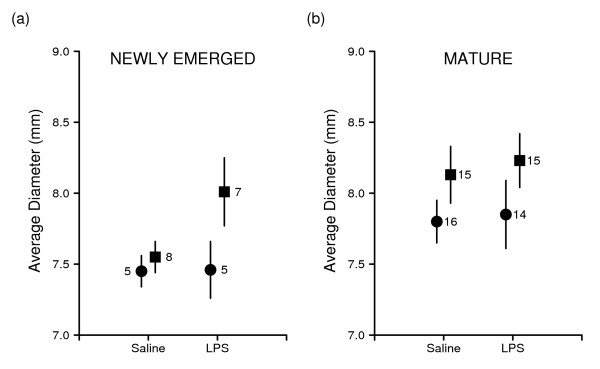
Mean average diameter of zones of antibacterial inhibition (± 1 SE) for males (circle) and females (square) of (a) newly emerged and (b) mature Enallagma boreale 12 h after injection of saline or LPS and held at 22°C. Numbers indicate sample size.